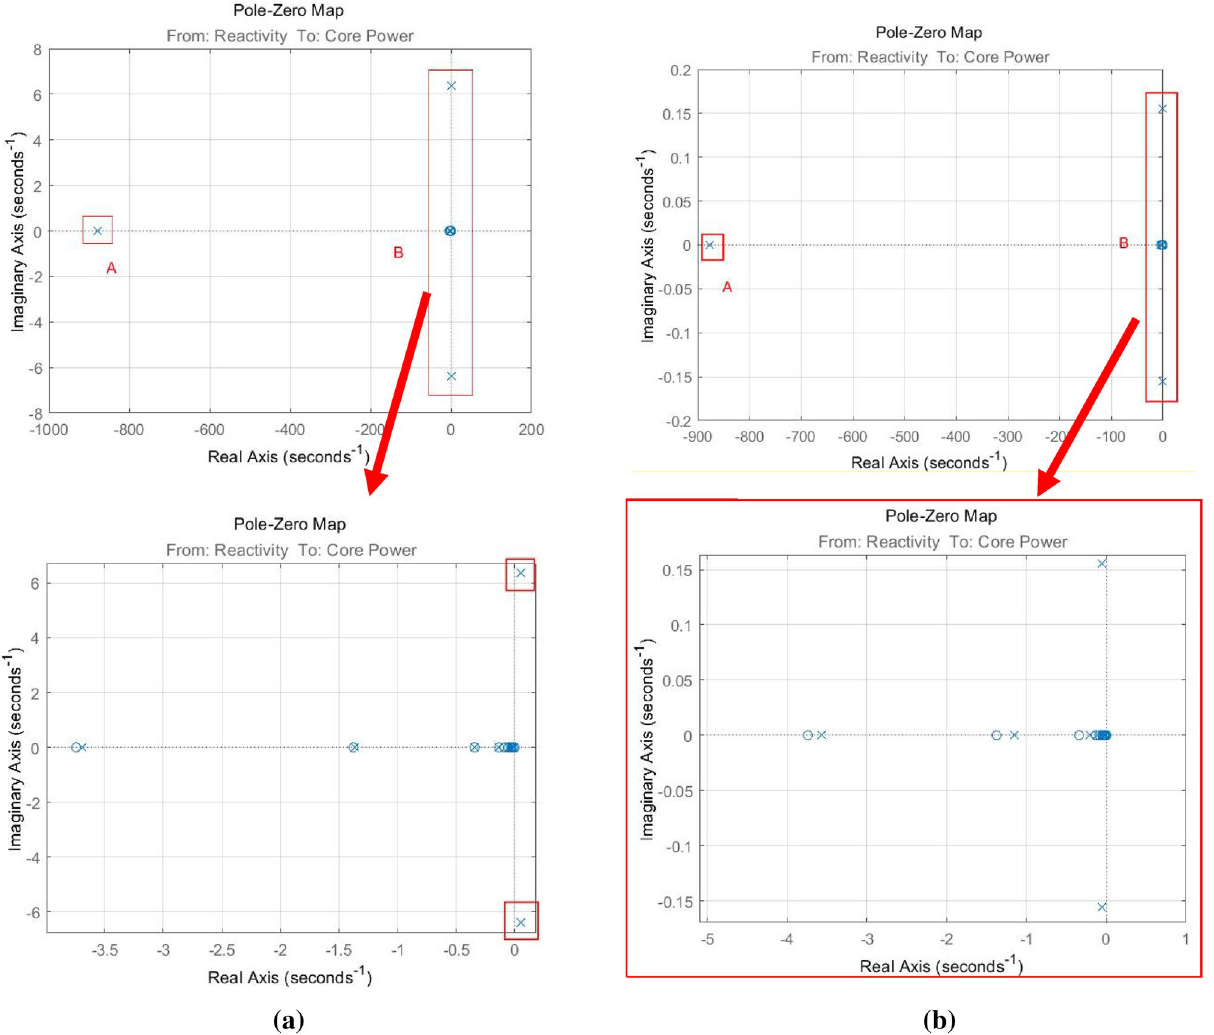
Figure 8. Closed loop poles and zeros distribution of the reactivity disturbance suppression system, ( a ) without correction, ( b ) with